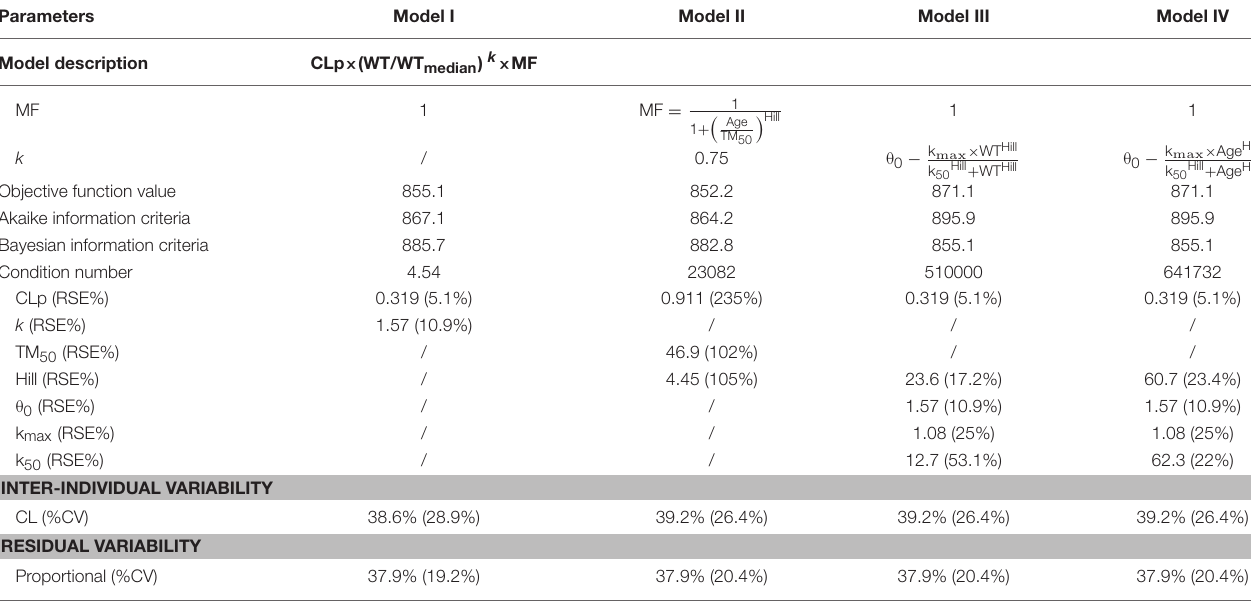
TABLE 2 | Population pharmacokinetic estimates of vancomycin of maturation model.